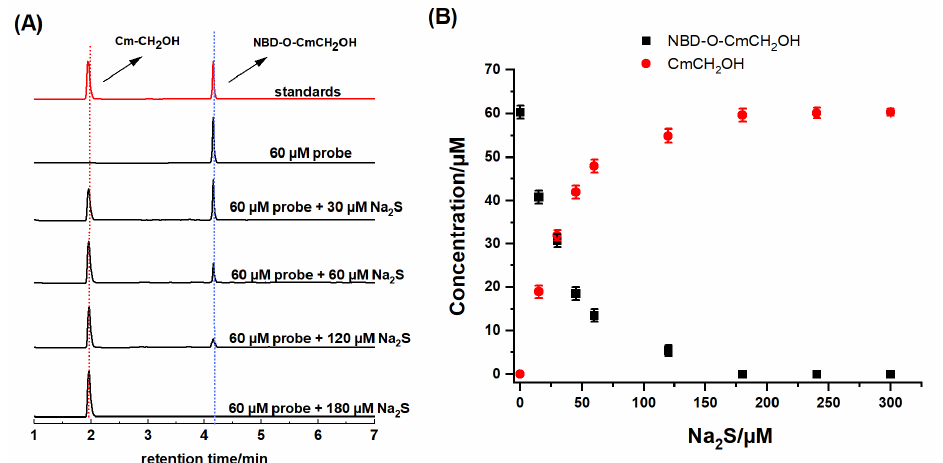
Figure 5. ( A ) HPLC chromatogram of the standards (60 μ M) and reaction mixtures of NBD-O- CmCH 2 OH (60 μ M) with Na 2 S (0–300 μ M) after 15 min incubation. The traces were collected using an absorption detector set at 330 nm. ( B ) HPLC-based titration of NBD-O-CmCH 2 OH (60 μ M) with Na 2 S after 15 min of incubation in solution. Data are means ± standard deviation of three independ- ent experiments.